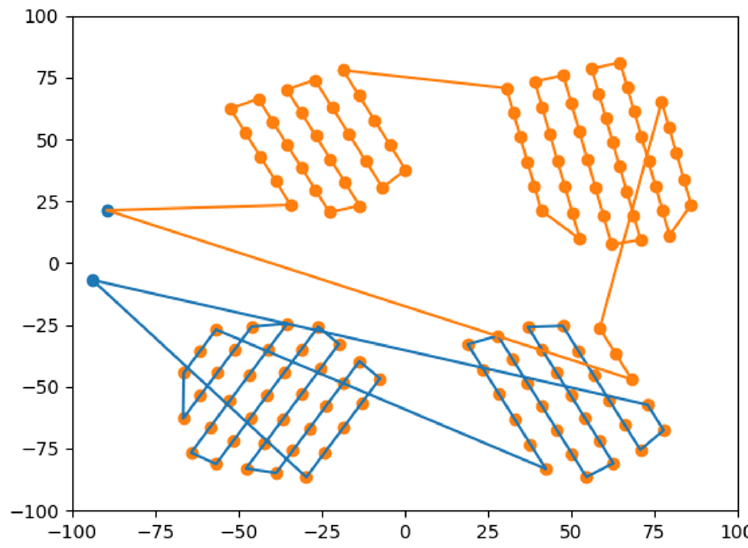
Figure 7. Powell-BINPAT task assignment.